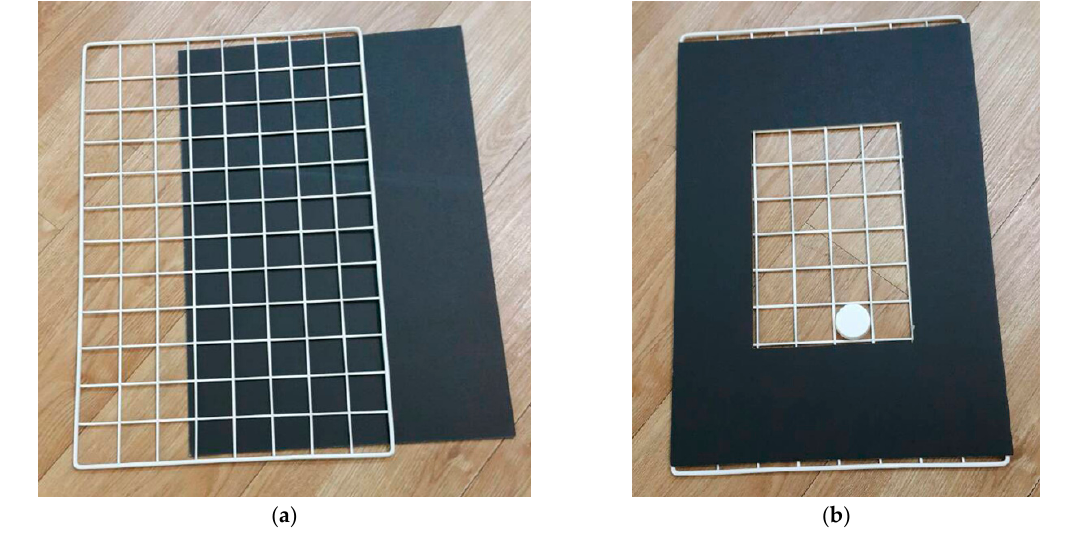
Figure 5. Photos of wire net and mounting board: ( a ) wire net and pre-cut mounting board; and ( b ) wire net with mounting board frame for laundry room game level.